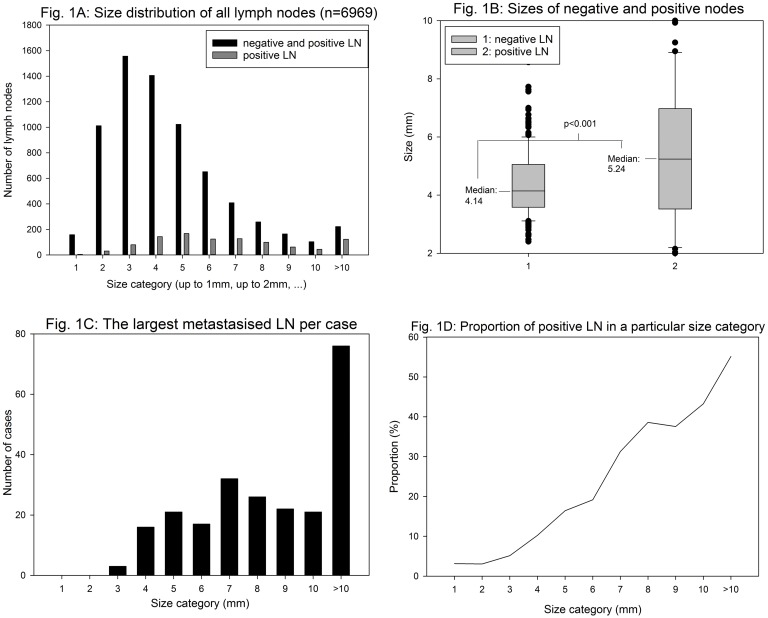
Size distribution of all lymph nodes (A); difference of size of negative and positive nodes (B); largest metastasised lymph node per case (C); percentage of positive lymph nodes in a particular size category (D).LN: lymph node.